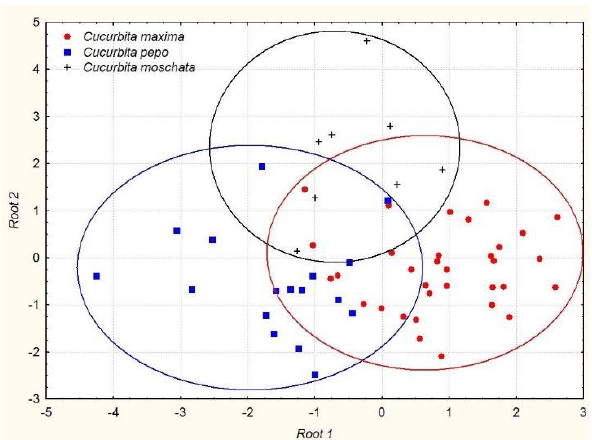
Figure 3. The discriminant analysis of hull, oil content and FA composition in seeds of C. pepo, C. maxima and C. moshata from the VIR collection.